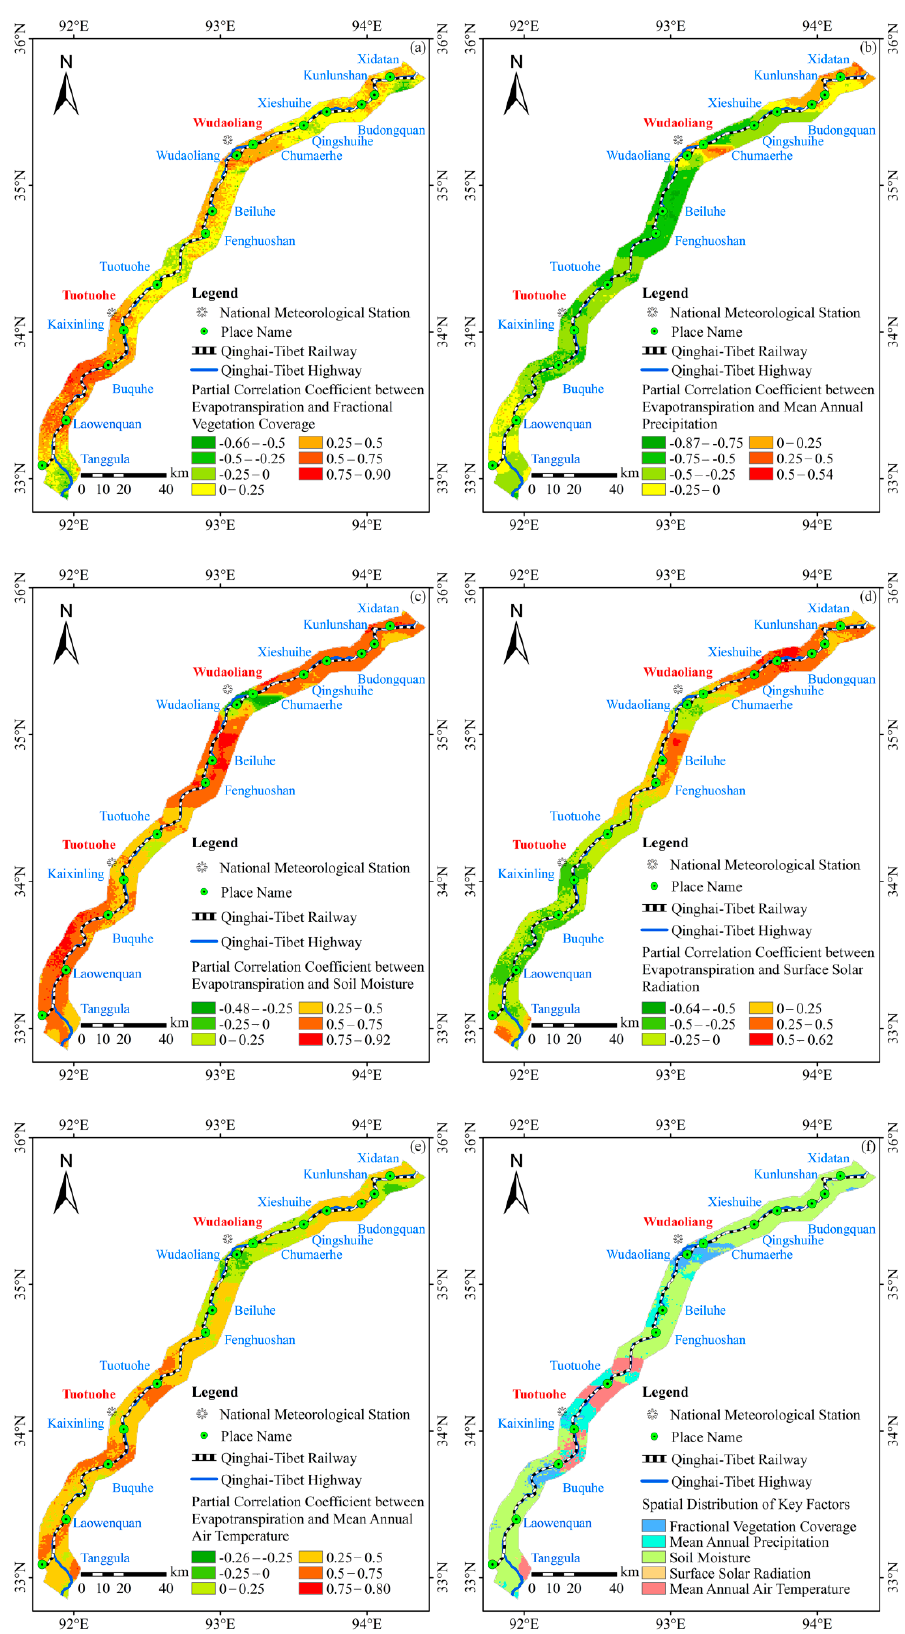
Figure 10. Spatial distribution of the partial correlation coefficient between ET and driving factors, and key factors affecting ET: ( a ) FVC; ( b ) MAP; ( c ) SM; ( d ) SR; ( e ) MAAT; ( f ) key factors.